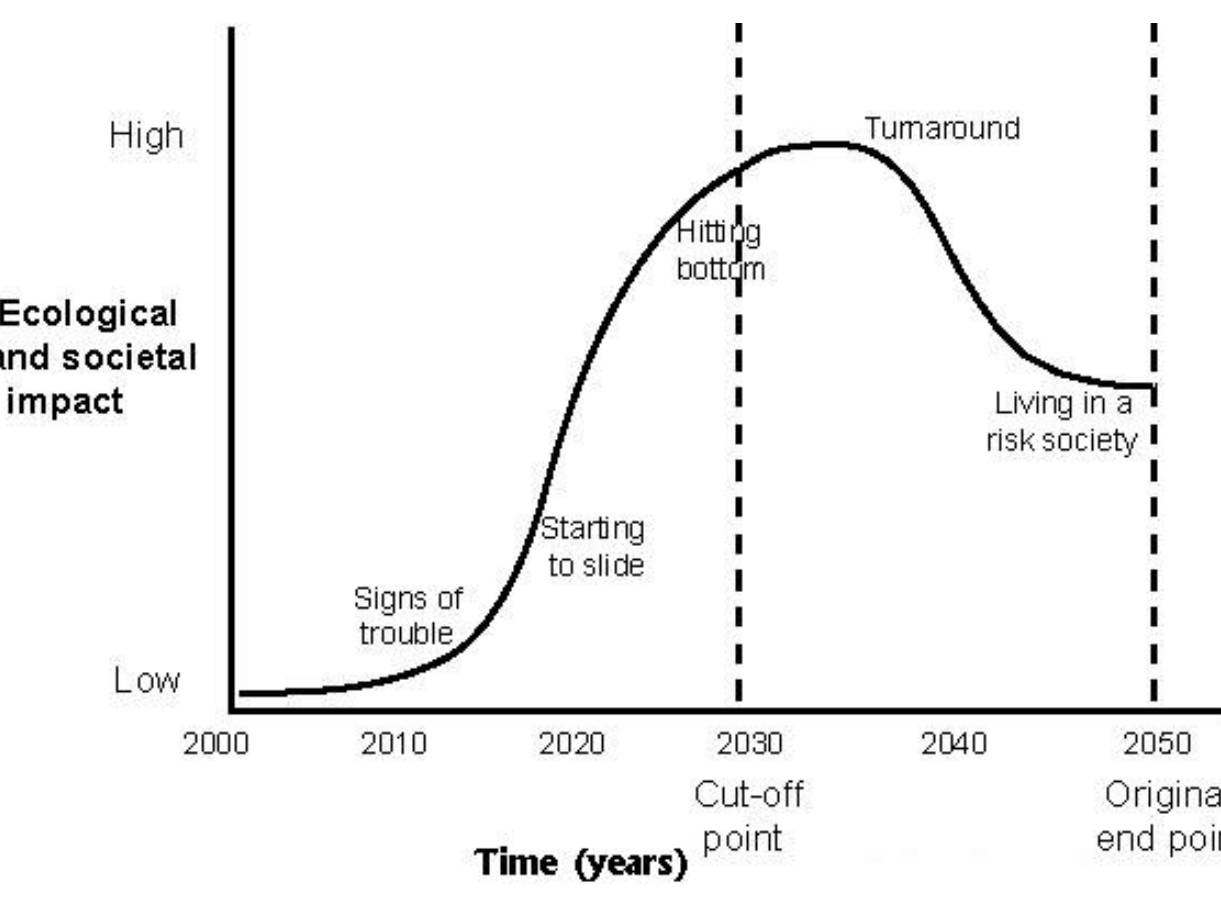
Fig. 3 . Overall ecological and societal impact with the progression of time in the MedAction Big Is Beautiful scenario. Reducing the timescale of the scenario can result in a markedly different or incomplete